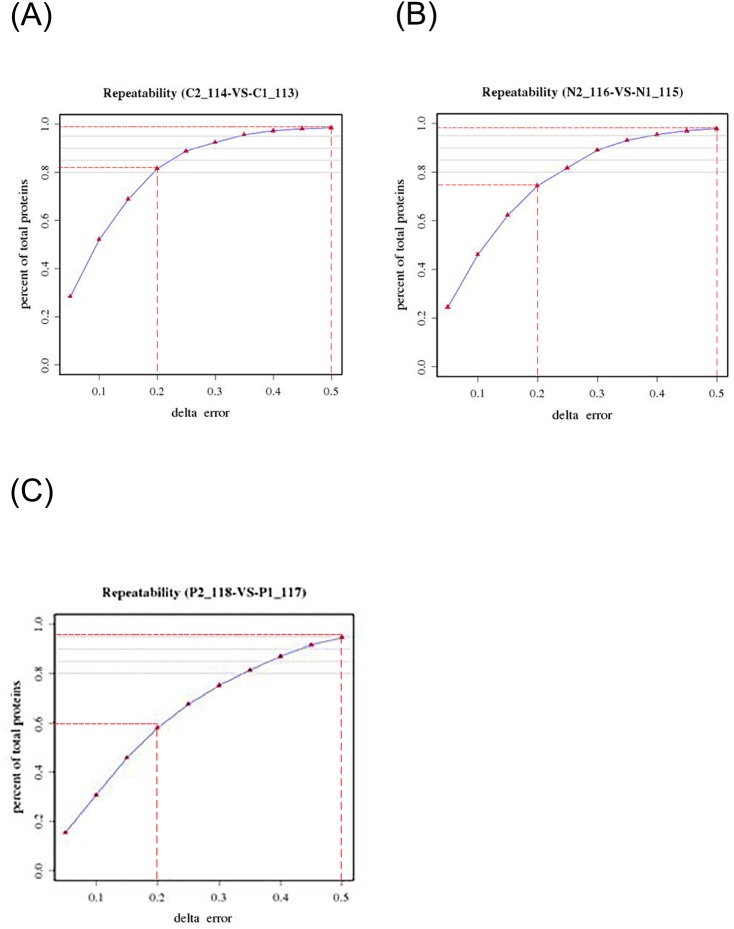
Good reproducibility between two biological replicates for each cultural condition, which indicated by the data that 95% of the proteins had differences with a delta error of less than 0.5 between two samples in all three conditions.(A) Control conditions; (B) N-limited culture conditions; (C) P-limited culture conditions.